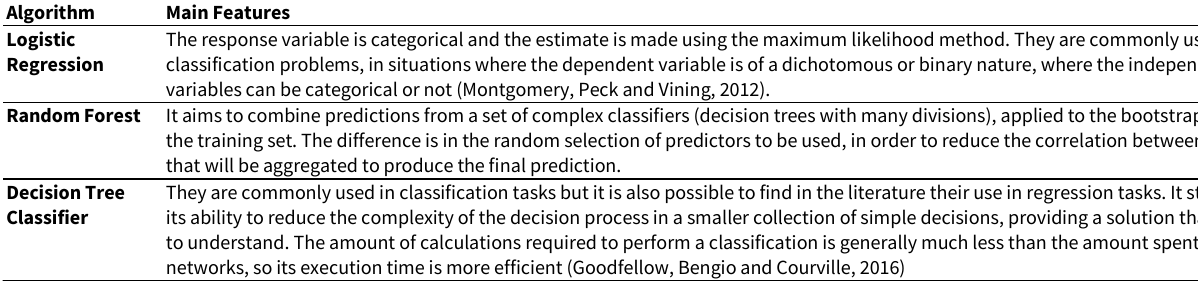
Table 1. Main Features of the Used